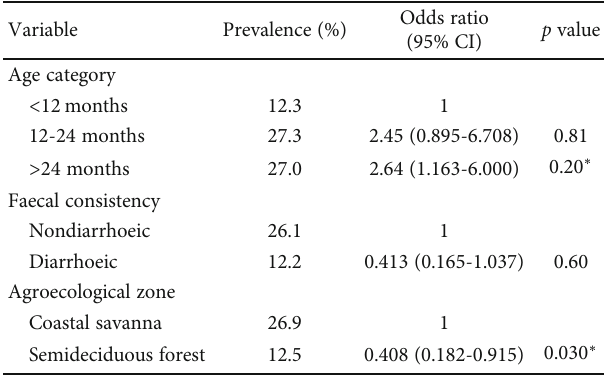
Table 3: Risk factors for Cryptosporidium infection among cattle in the Central